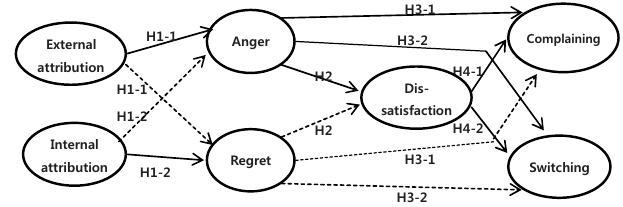
Figure 1: The research